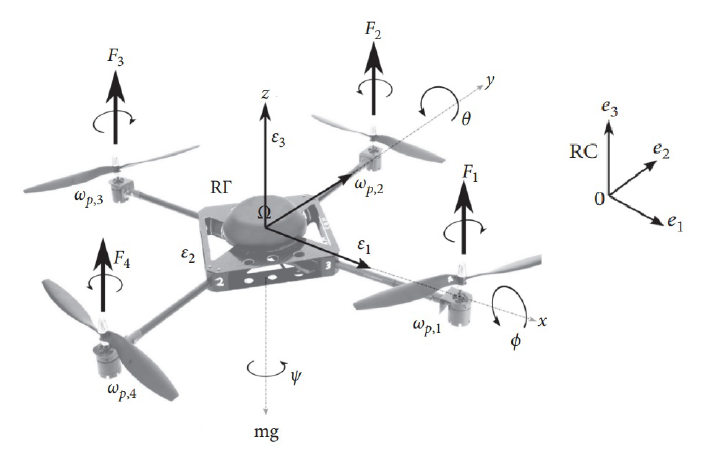
Figure 1. Quadrotor orientation using Euler